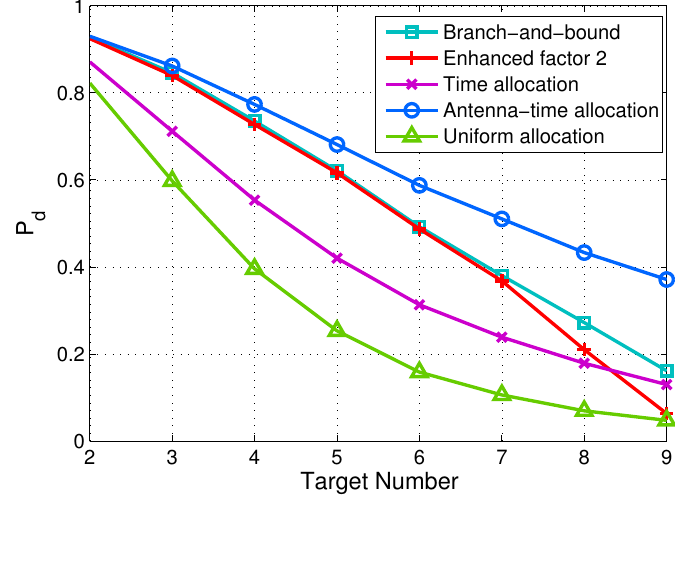
Figure 8. Minimum detection probabilities of targets versus target number via five allocation = 5 and 0 dB target RCS fluctuation. P methods. M = 9 , N = 9 , σ 2 w